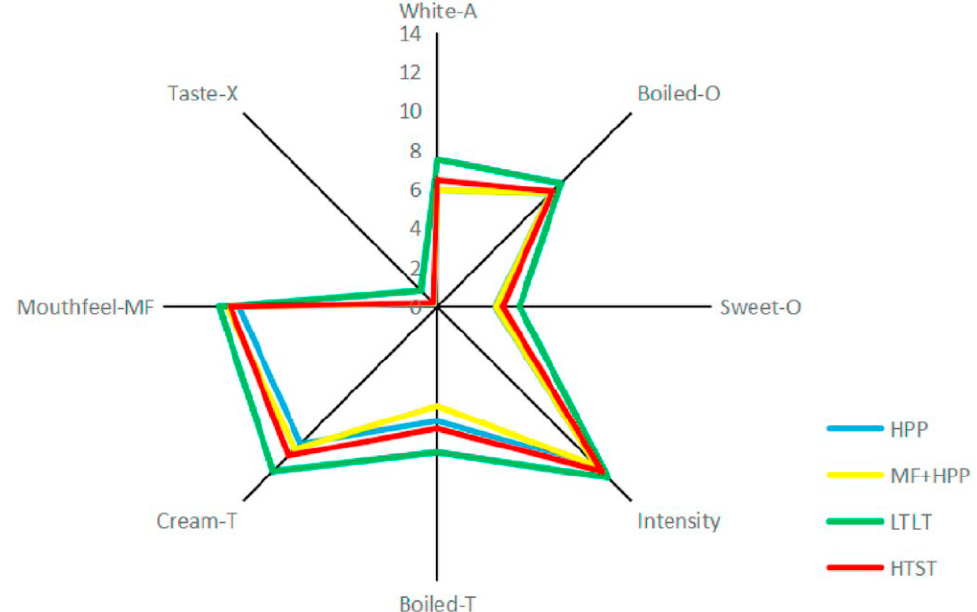
Figure 8. Sensory analysis comparison of LTLT (low-temperature, long-time), HTST (high-temperature, short-time), HPP (high-pressure processing), and MF + HPP (microfiltration + HPP) milk regarding appearance (A), odor (O), taste (T), intensity, mouthfeel (M), and off-taste (X). Adapted from [13]. Reproduced with permission from Guanchen Liu, Christina Carøe, Zihan Qin, Daniel M.E. Munk, Michael Crafack, Mikael A. Petersen, Lilia Ahrné, Comparative study on quality of whole milk processed by high hydrostatic pressure or thermal pasteurization treatment; published by Elsevier, 2020.